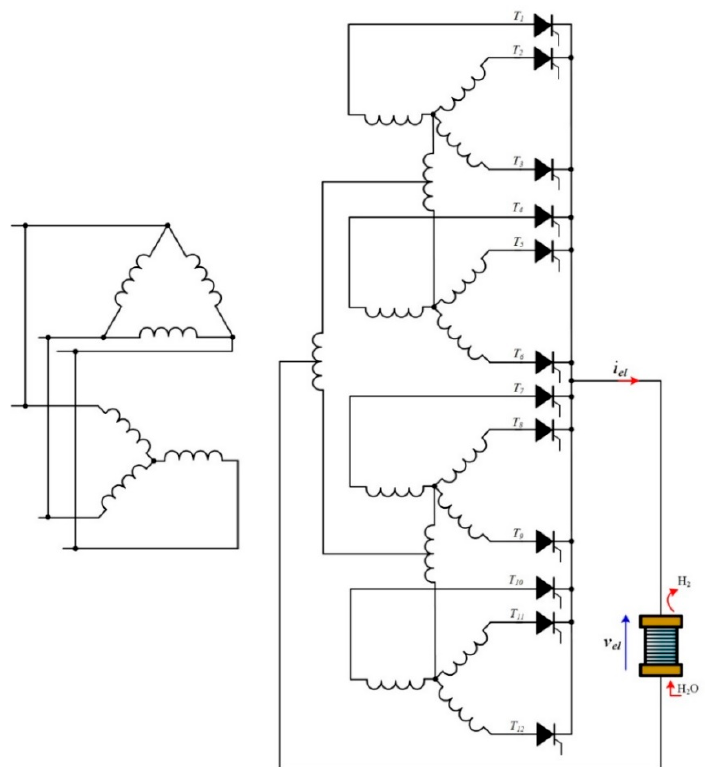
Figure 10. Six-pulse thyristor double-star rectifier.